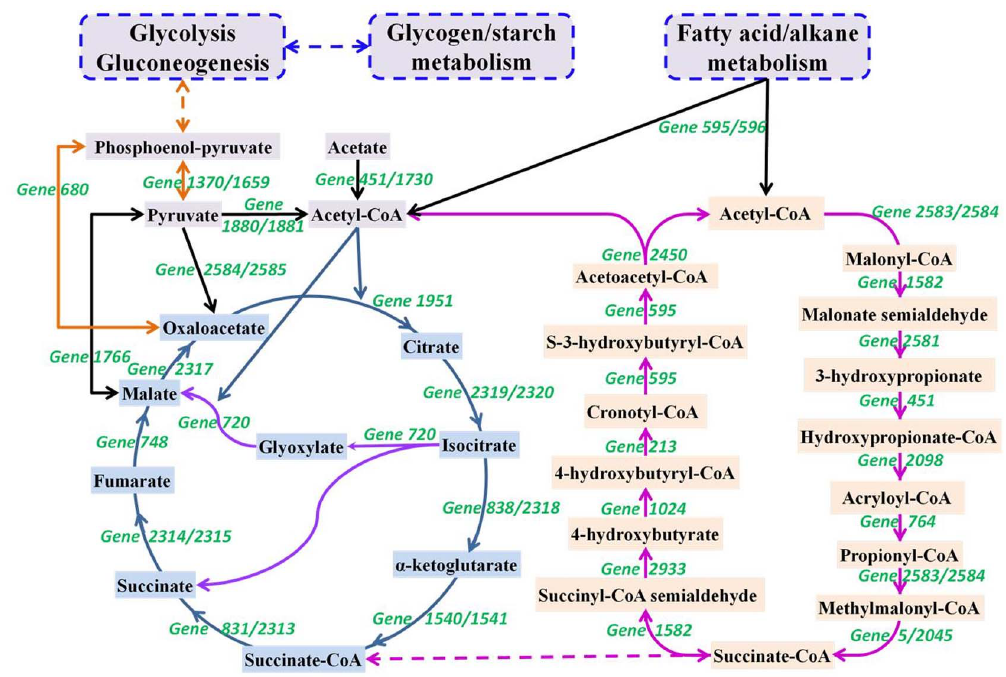
Figure 3. Putative metabolic pathway of SBR1093 HKSP (based on the genetic analysis). Carbon fixation with the HPHB cycle is used for the biomass synthesis via the transfer of acetyl-CoA to the citrate cycle or gluconeogenesis, and the genes responsible for each step are marked with green words. Intermediates connected with colored lines represent different metabolic pathways.